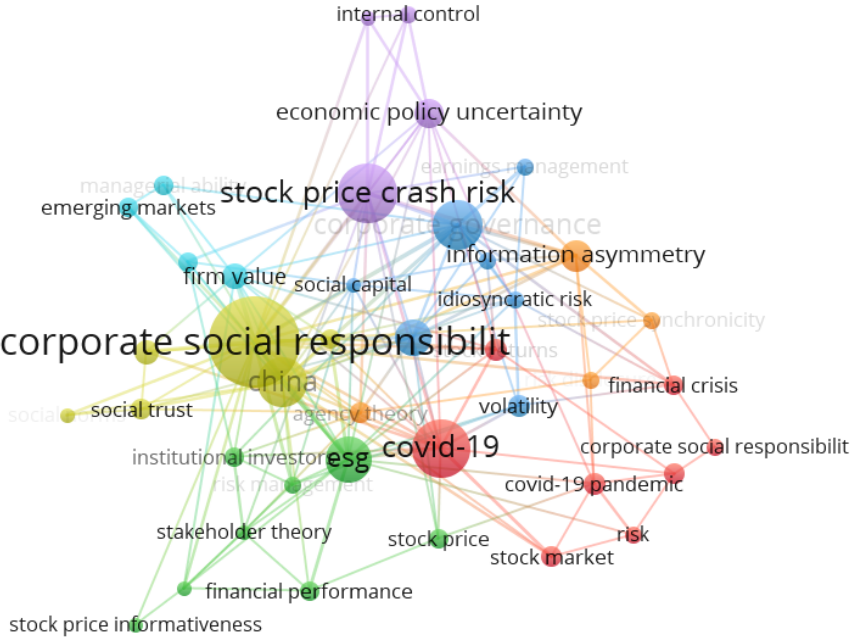
Figure 7. Network visualization–co-occurrence of author keywords. Source: Scopus/VOSviewer.